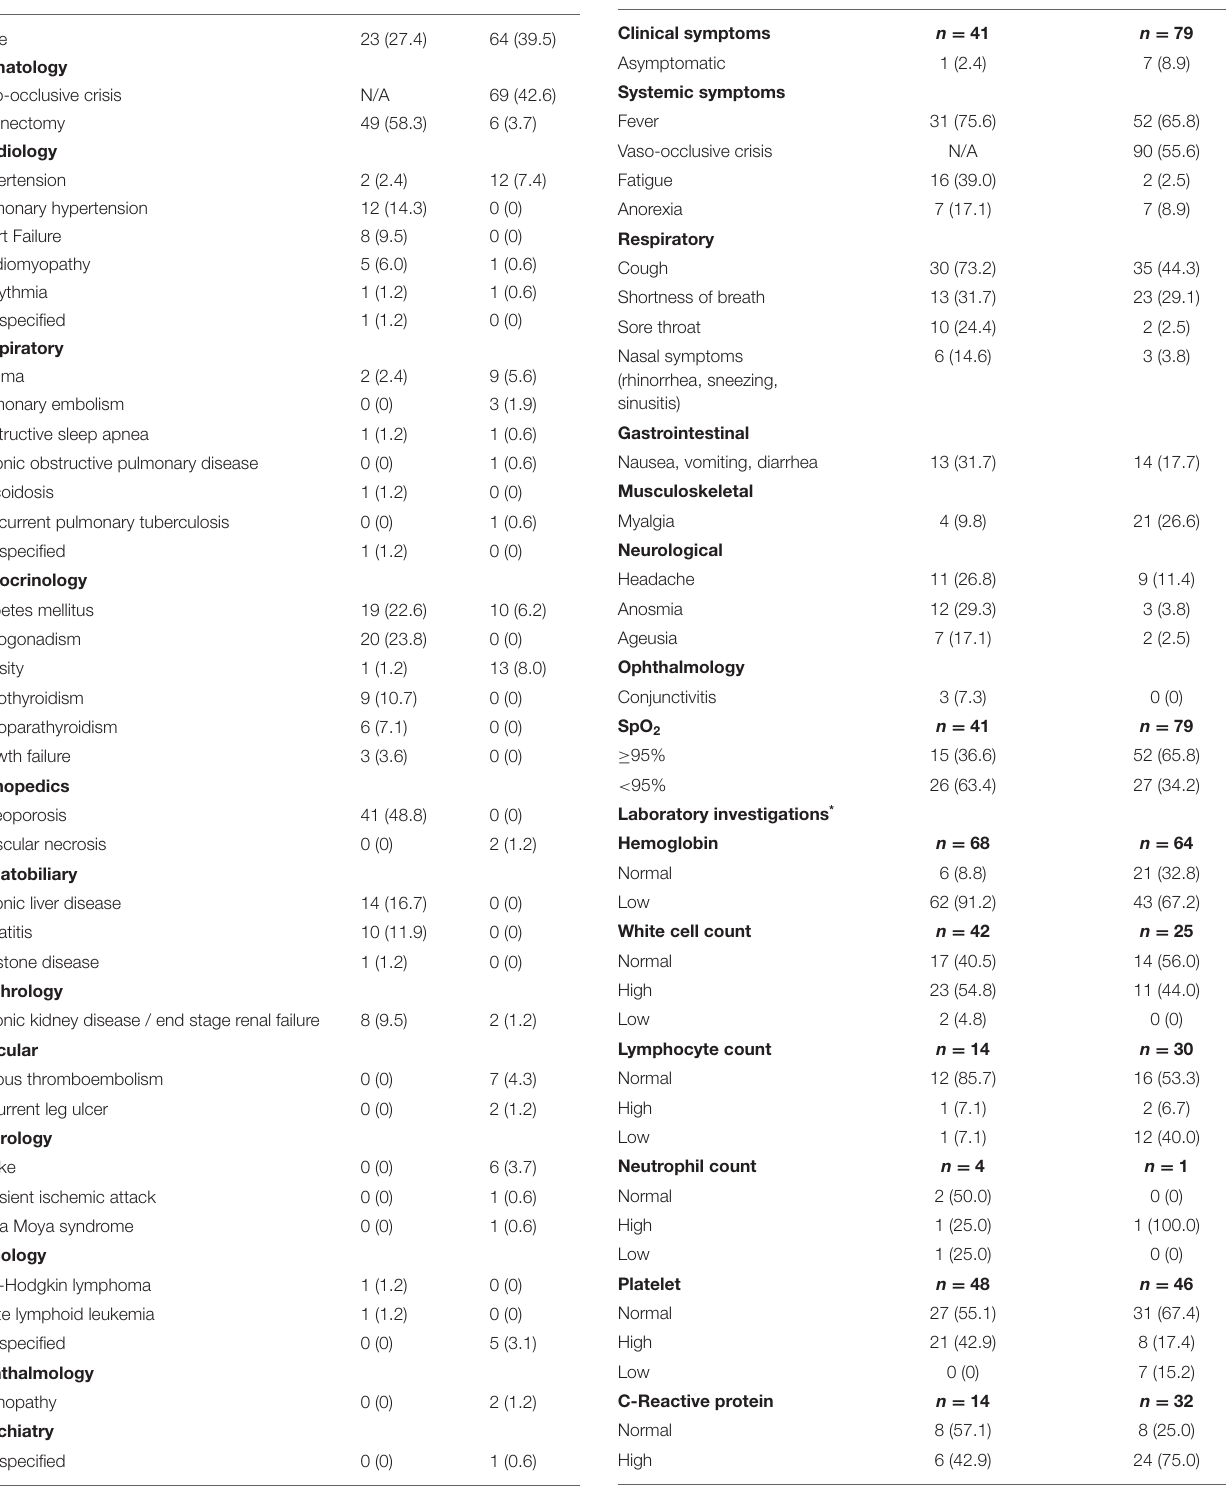
TABLE 3 | Summary of clinical presentations, laboratory investigations and radiological imaging of the study population.